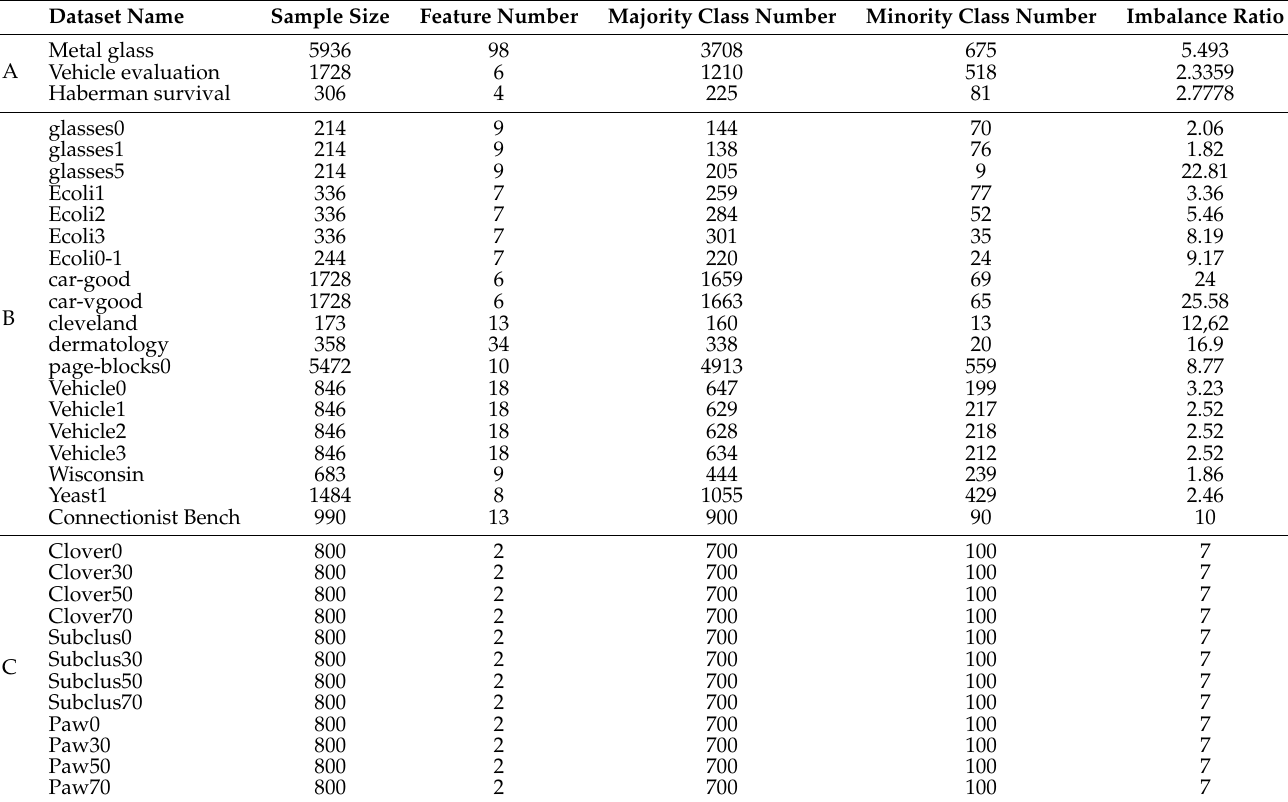
Table 1. Detailed description of the three experimental